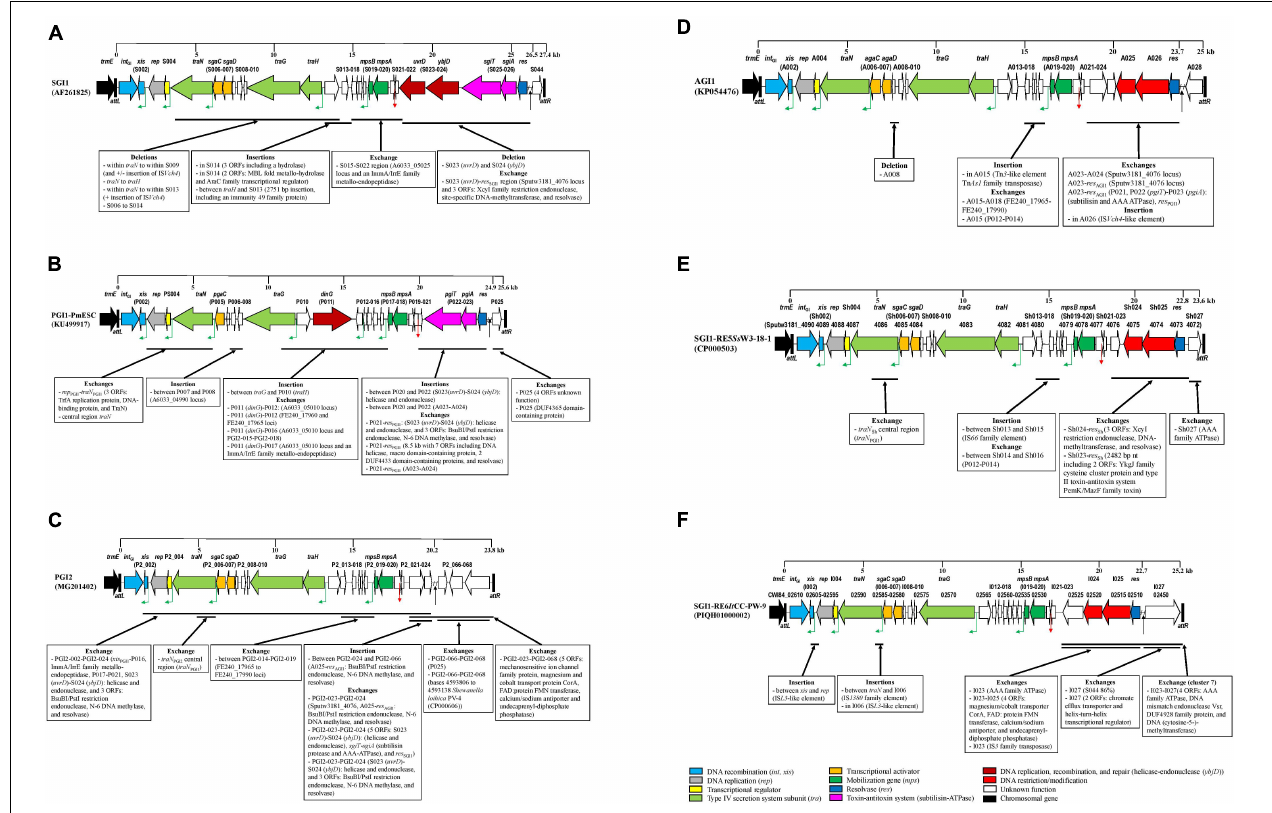
FIGURE 3 | Backbone variations of SGI1-REs of each cluster compared to the SGI1-RE used as a reference. (A) cluster1: SGI1 cluster, (B) cluster 2: PGI1 cluster, (C) cluster 3: PGI2 cluster, (D) cluster 4: AGI1 cluster, (E) cluster 5, and (F) clusters 6 and 7. The original reading frames (ORFs) of the backbone used as a reference are represented. The following colors are used for the ORFs of known function: light blue, DNA recombination ( int , xis ); gray, DNA replication ( rep ); yellow, transcriptional regulator; light green: type IV secretion system subunit ( tra ); orange, transcriptional activator; dark green, mobilization gene ( mps ); dark blue, resolvase ( res ); pink, toxin-antitoxin system (subtilisin-ATPase); dark red, DNA replication, recombination, and repair [helicase-endonuclease ( ybjD )]; red, DNA restriction/modification; white, unknown function; and black, chromosomal gene. The green angled arrows indicate AcaCD binding sites, the red arrow indicates oriT , and the black arrow indicates the MDR region. Black vertical lines represent attL and attR attachment